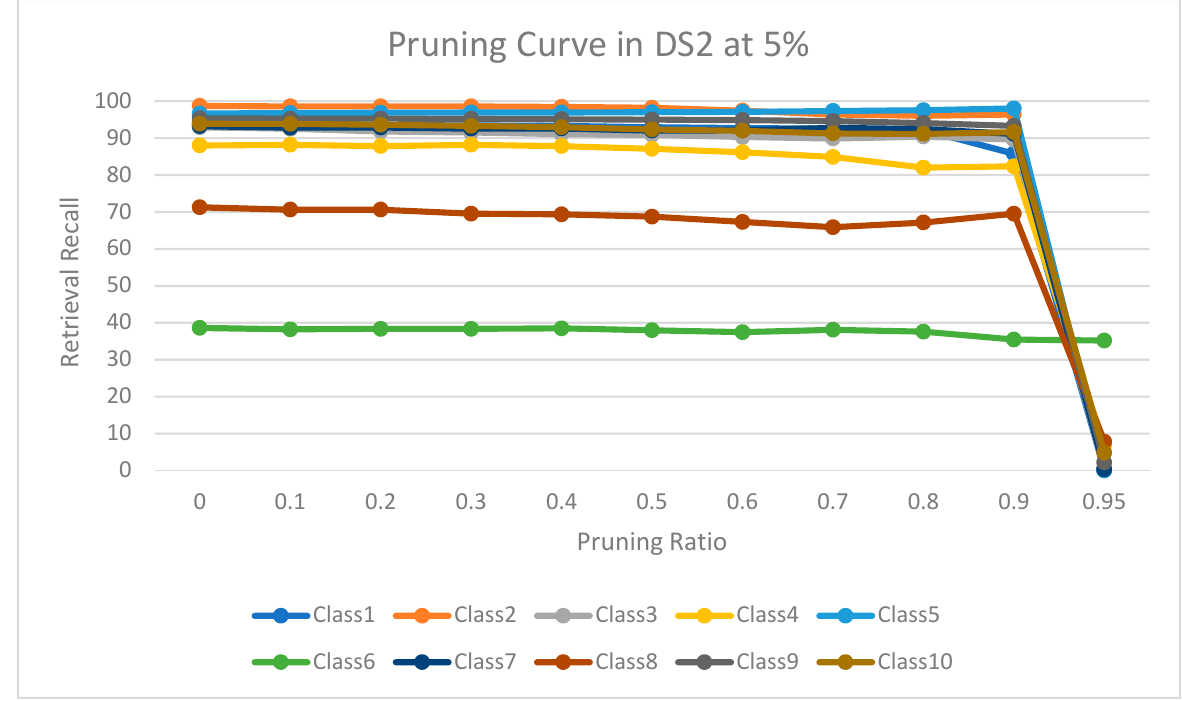
Figure 7. the level of retrieval recall values at different percentages of pruning at the top 5% in MDDR-DR2.